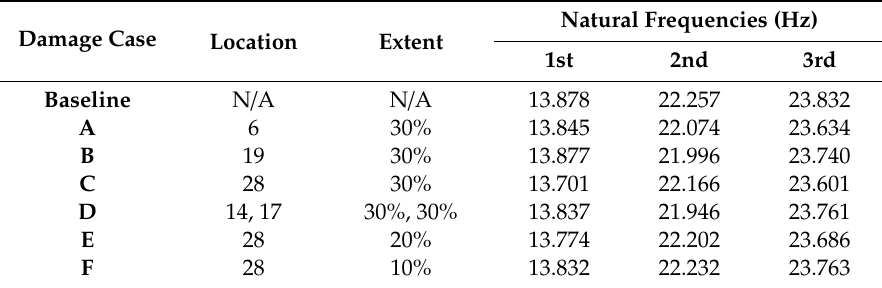
Table 1. The simulated damage cases of the truss